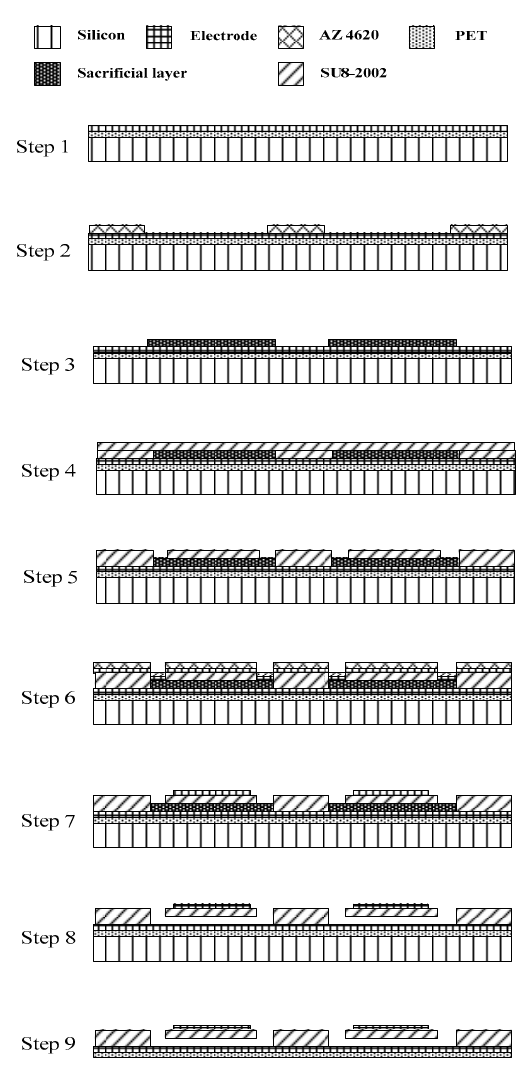
Figure 4. CMUT made by the sacrificial-layer fabrication technique.